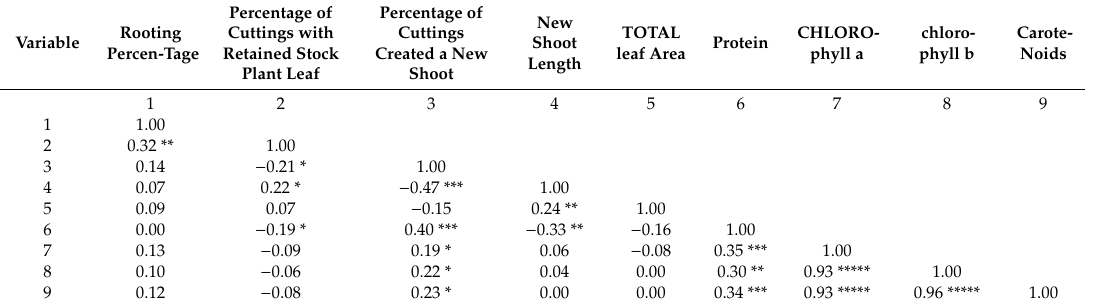
Table 6. Correlations matrices between rooting percentage and growth parameters, pigments, and soluble proteins content for cutting derived from shoots immediately after petal shedding in Rosa ‘Maiden’s